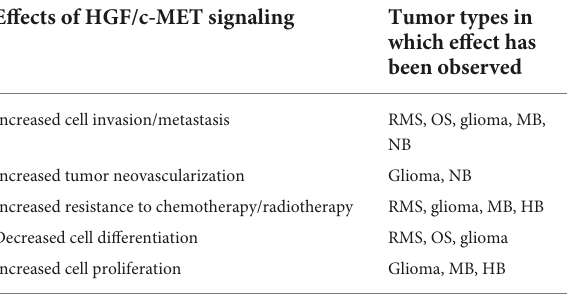
TABLE 1 Effects of the HGF/c-MET pathway in pediatric